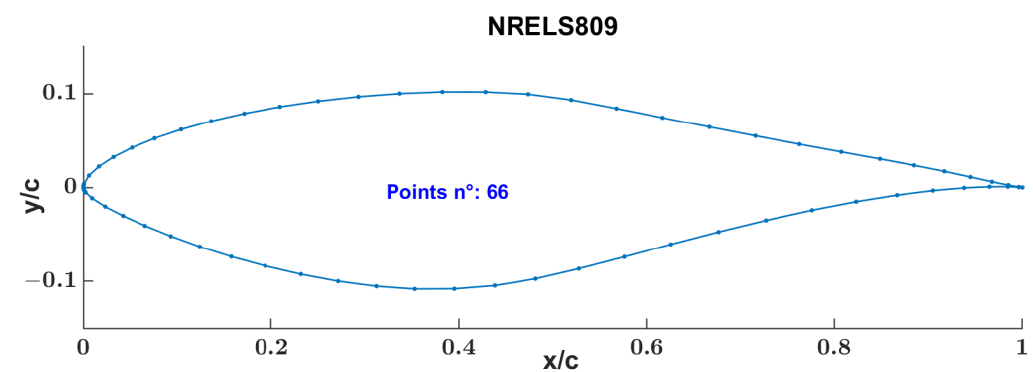
Figure 23. NREL ’ s 809 input airfoil.